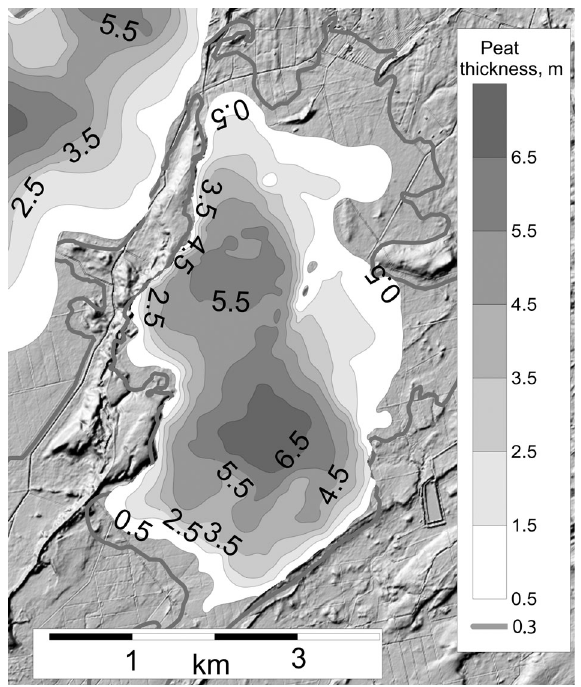
Fig. 5. Peat thicknesses in the Selisoo mire. The peat layer is thickest in the southern part of the mire. The dark grey line marks the border of the former mire before establishment of forest drainage systems.